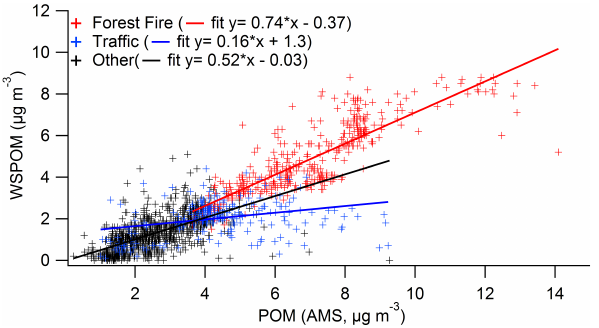
Fig. 4. Concentration of water-soluble particulate organic mat- ter versus carbon monoxide concentration for different sources of WSPOM. The equations ( y = kx + b ) of fitted curves represented after each